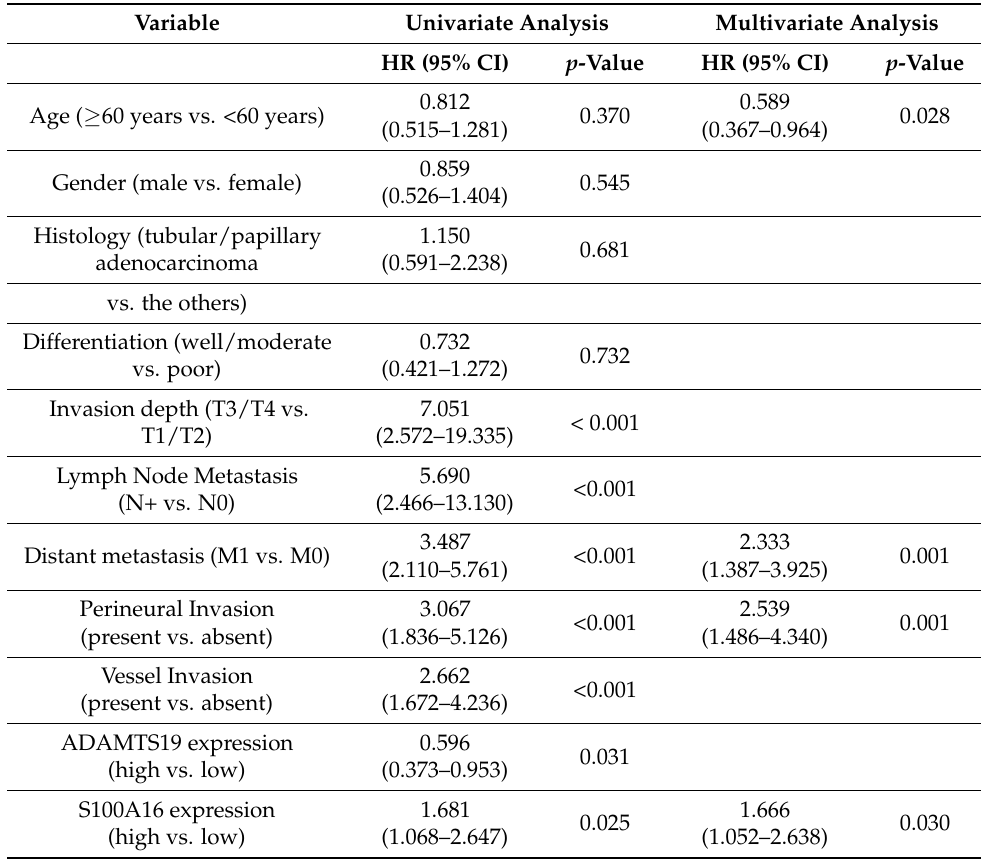
Table 2. Univariate and multivariate analyses for the prognostic factors of overall survival in gastric cancer patients ( n =